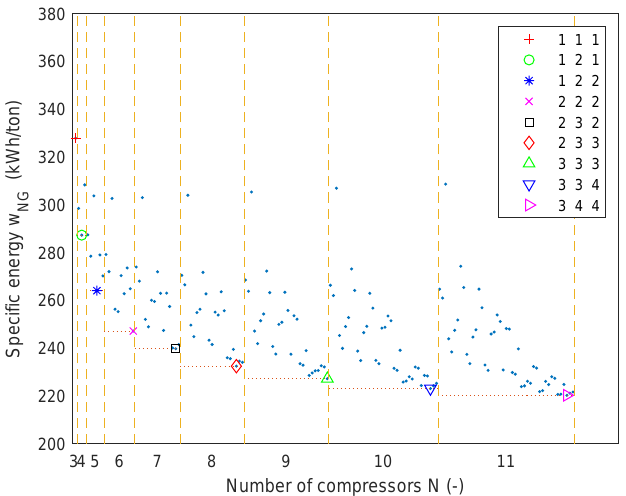
Figure 7. Optimized for all different n R 290 - n R 1150 - n R 50 -Cascade process configurations with N = n R 290 + n R 1150 + n R 50 compressor